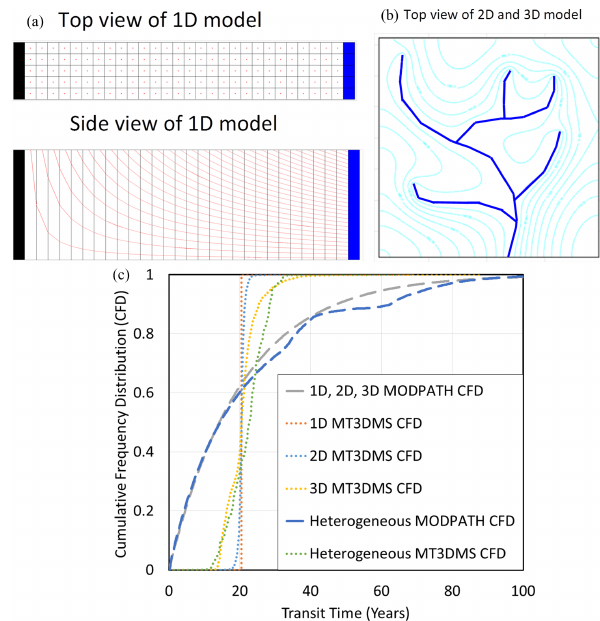
Figure 6. (a) 1-D conceptual model, (b) 2-D conceptual model, and (c) MODPATH and MT3DMS CFDs developed for a 1-D, 2-D, and 3-D conceptual model (dispersion and diffusion transport was dis- abled in the